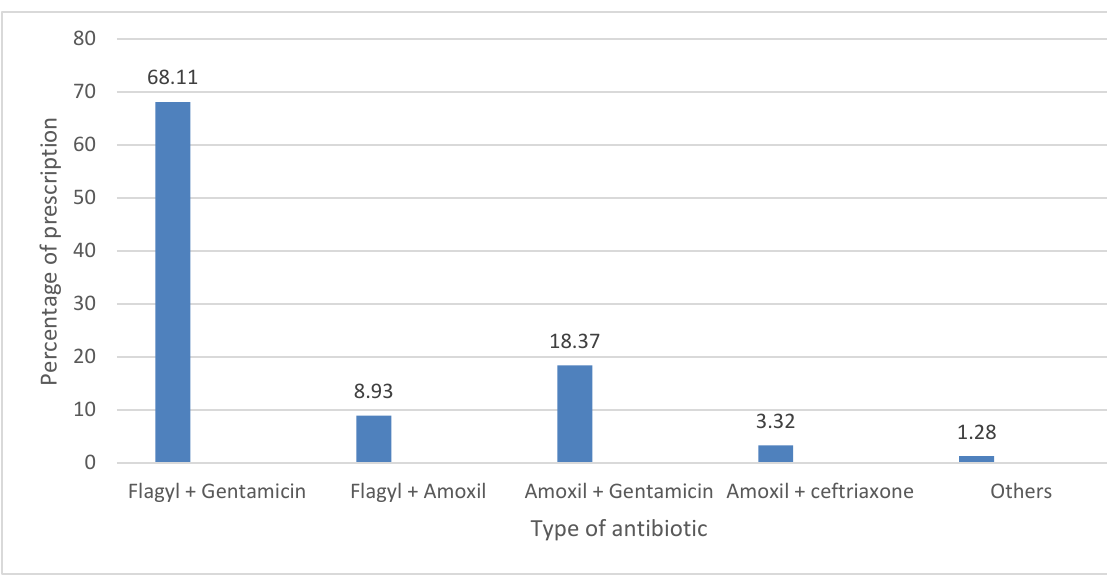
Figure 5: Single antibiotics prescribed in emergency department (Total